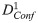
Correlation between estimated average binding energies (Ebind, kcal mol-1) and the experimental binding free energies (ln(KD), where KD is in nM).(a) Data for 12 different ssDBP–ssDNA (red) and three different ssRBP–ssRNA (blue) systems whose structures and dissociation constants are known. (b) Data for the cold-shock protein (13 ssDNA ligands in solid red, and nine ssRNA ligands in solid blue). To test the effect of ligand flexibility on binding, the dihedral potentials of ssDNA and ssRNA were interchanged such that the ssRNAs become more flexible than the ssDNAs. Corresponding trend shows that their binding energies also interchanged such that ssRNAs could bind the protein tighter than ssDNAs, so depicting the key role of flexibility in protein–ssDNA/ssRNA interactions. The solid and dashed lines are the linear correlation between the calculated binding energy and the experimental KD for the ssDNA/ssRNA with the original or interchanged flexibility, respectively (with correlation coefficients of 0.64 and -0.17, which were obtained after excluding the data point of low affinity). For each ligand, the average binding energy was calculated by considering only those conformations that are similar to the experimental structure (DConf1 and DConf2 ≤5 Å). The trend line and corresponding Pearson correlation coefficients are reported.